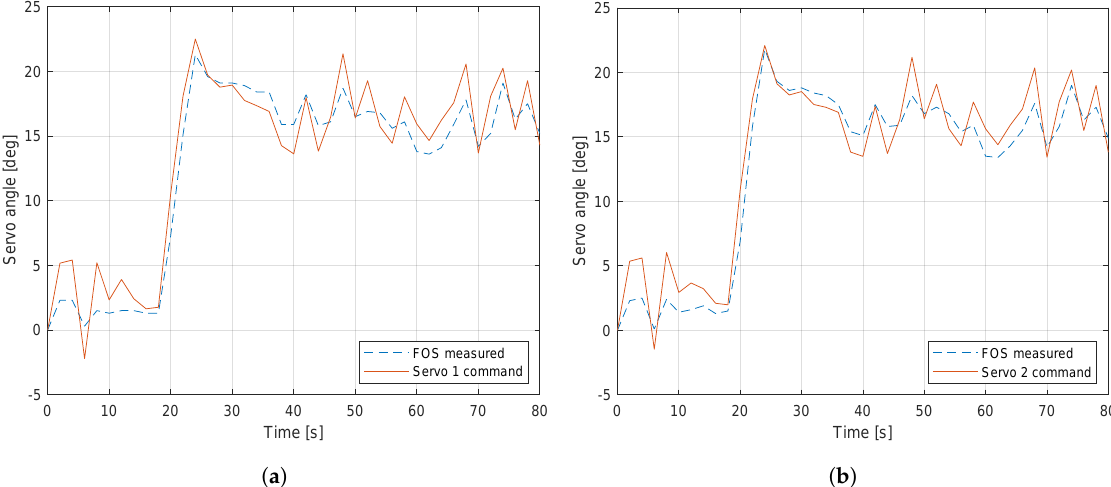
Figure 11. Estimated position with respect to module #1 deflections for the F y = 25 and M x = 0 case. The positions of actuators 1 and 2 are separated and shown in ( a , b ), respectively.